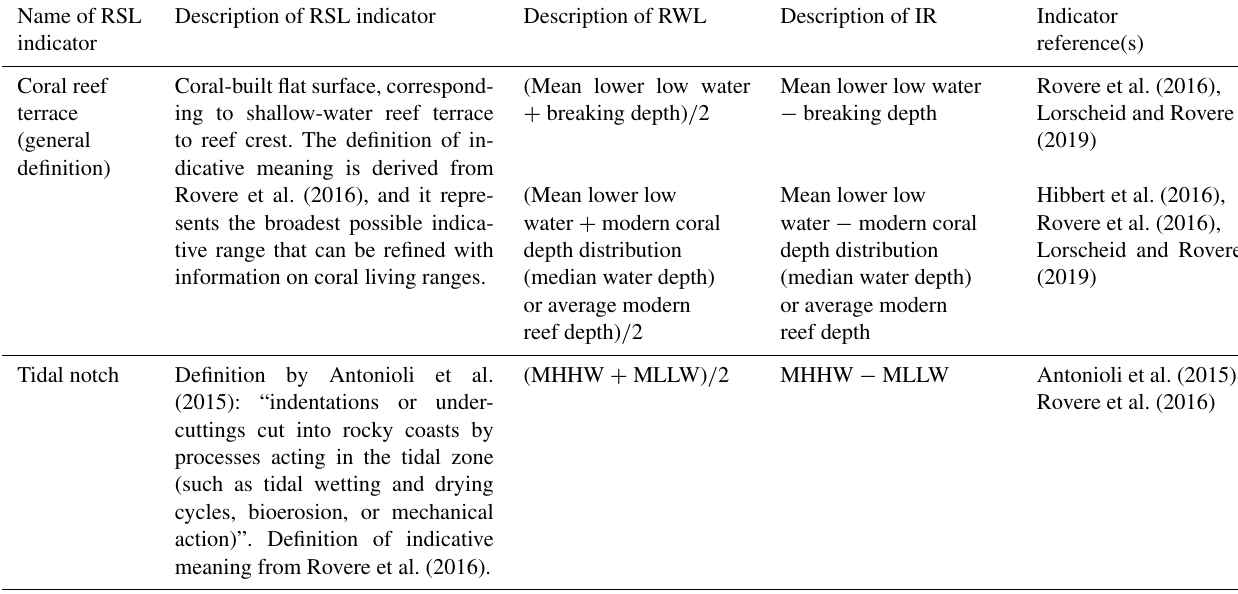
Table 1. Different types of RSL indicators reviewed in this study and the descriptions of their reference water level (RWL) and indicative range (IR).